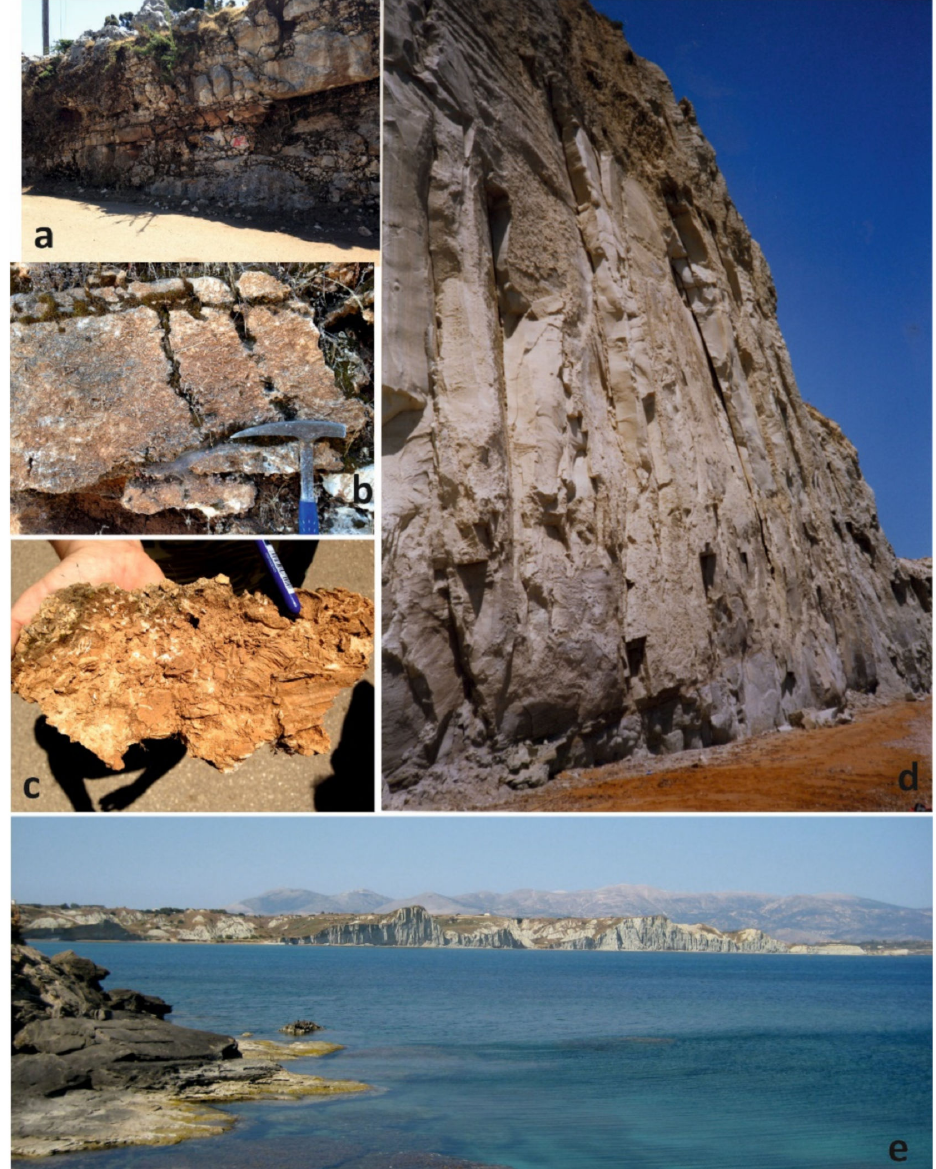
Figure 9. Selected geosites on Kefalonia island, for coding see Figure 4: ( a , b ) Upper Cretaceous thin- to thick-bedded limestones with rudist fragments on Mount Ainos (K11); ( c ) rudist fragments on Mount Ainos (K11), detail of the transported and fragmented shells; ( d , e ) Xi beach (K18) with blue clayey cliffs and maroon-colored sand. Photos ( a – e ) courtesy M.V. Triantaphyllou, I.